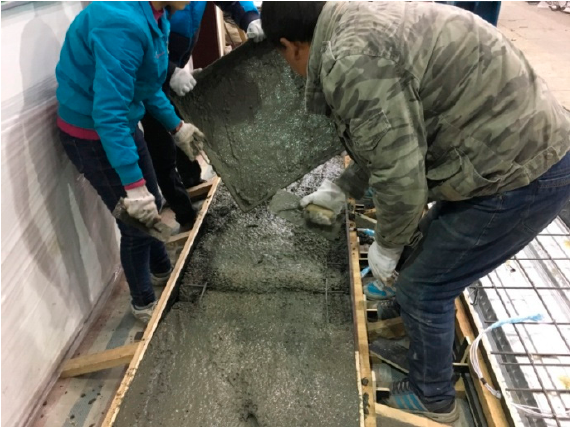
Figure 3. Manufacturing procedures of self-compacting rubber lightweight aggregate concrete (SCRLC) composite slab specimens.